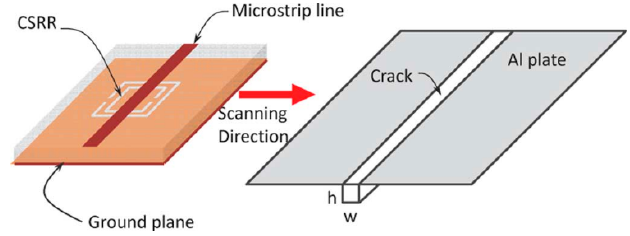
Figure 13. Schematic showing the microstrip line fed CSRR sensor and the scanning procedure (from [38]; copyright © IEEE 2012; reproduced with permission).